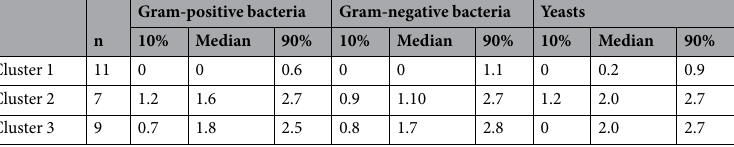
Table 2. Antimicrobial activity of peptides groups, transformed to -log(MIC/512), as a function of microorganism class. The 10%, 50% and 90% quantiles are